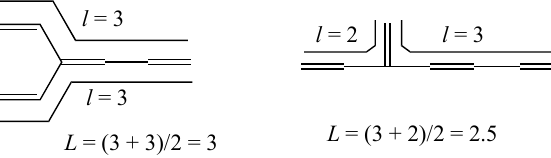
Figure 1. Calculation of mean length of conjugation L for 4-2 and 4-3 , both with T = 1.